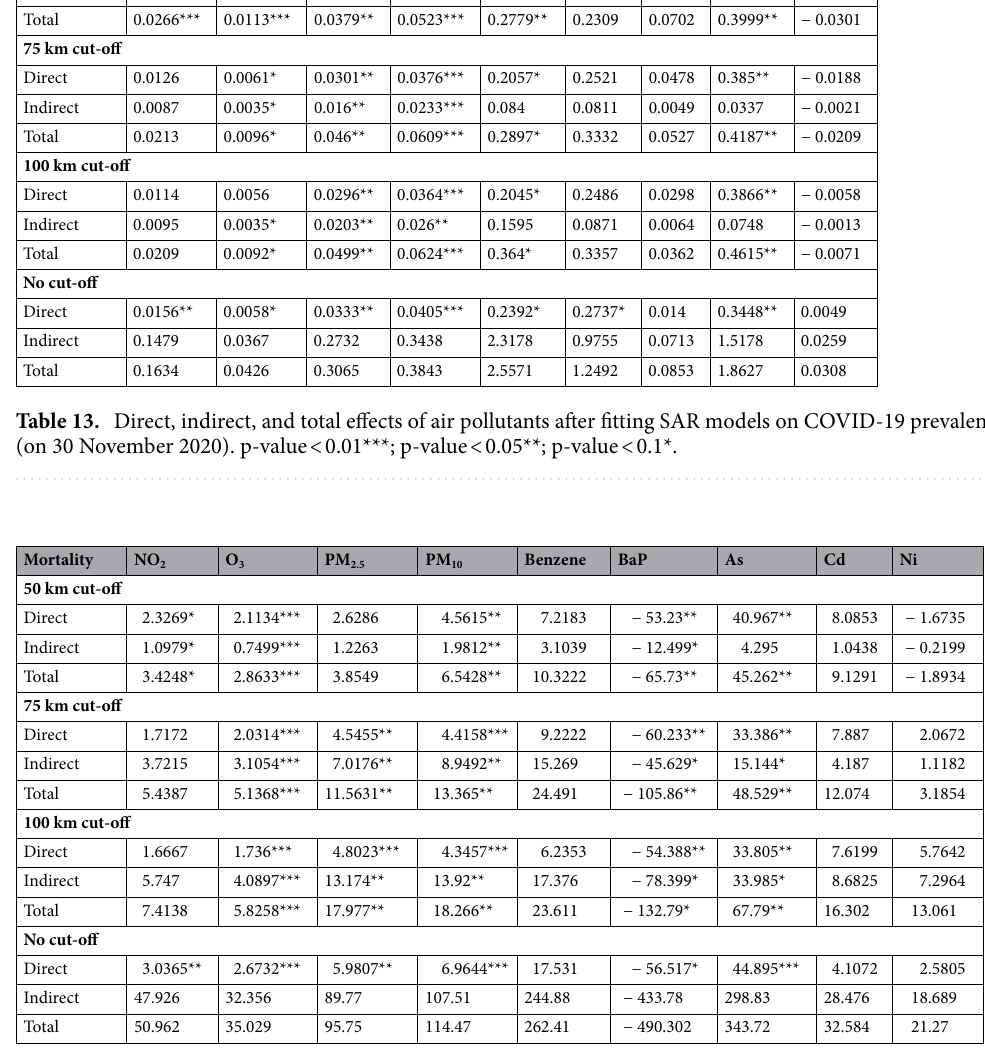
Table 14. Direct, indirect, and total effects of air pollutants after fitting SAR models on COVID-19 related mortality (on 30 November 2020). p-value < 0.01***; p-value < 0.05**; p-value < 0.1*.